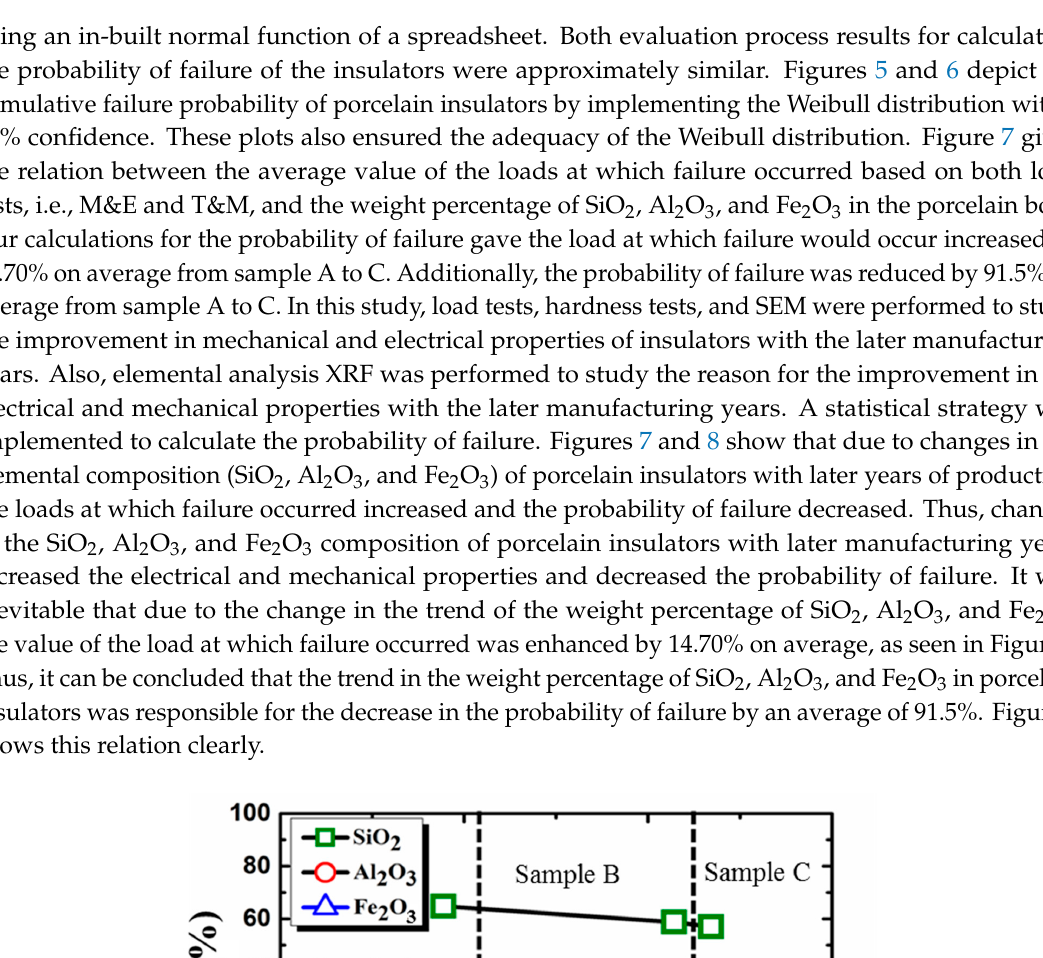
Figure 8. Probability of failure of samples A, B, and C based on the weight percentage of the porcelain constituents. 4. Conclusions An insulators must withstand rigorous stress as it is an outdoor device. Due to this, the aging cycle is hastened in insulators, which affects the mechanical and electrical characteristics of the insulators. Although an initial visual inspection is possible, almost all cases require experimental and statistical studies for a proper prediction of failure. This paper studied insulator samples that were collected from different power utilities in South Korea and had a weight of 36,000 lbs and operated at 154 kV. It was observed from load test and hardness test results that with later manufacturing years, the load at which failure occurred increased by 14.7% in average. K increased by 90.9% on average in the case of sample C compared to A. Characterizations using XRF and SEM